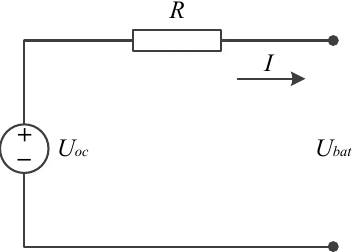
Figure 1. Equivalent circuit of battery Rint model.